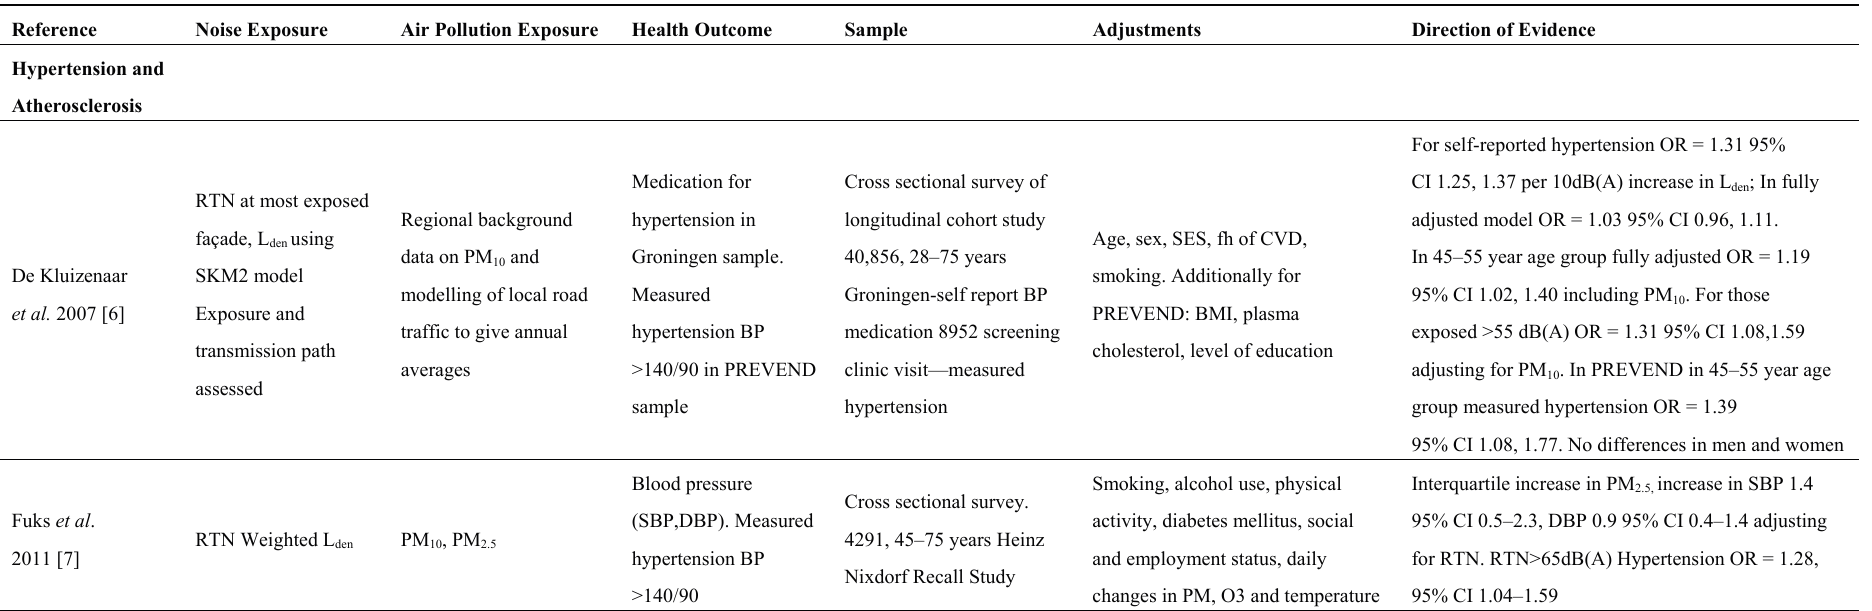
Table 1. Studies of air pollution and noise: effects on